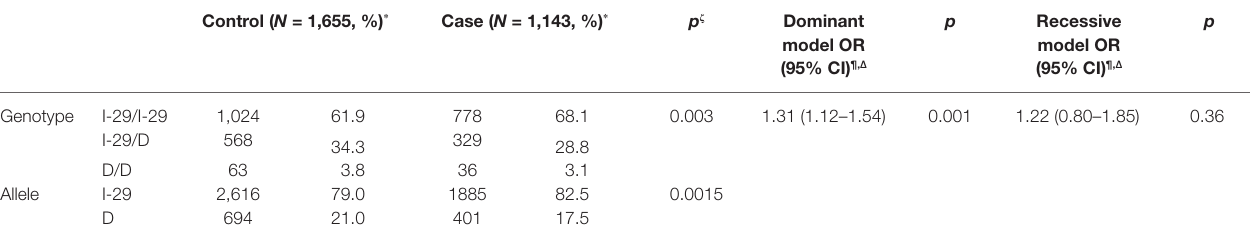
TABLE 2 | Association between NRH:quinone oxidoreductase 2 (NQO2) tri-allelic polymorphism and breast cancer risk in the whole study population. Control ( N = 1,655, %) * Recessive